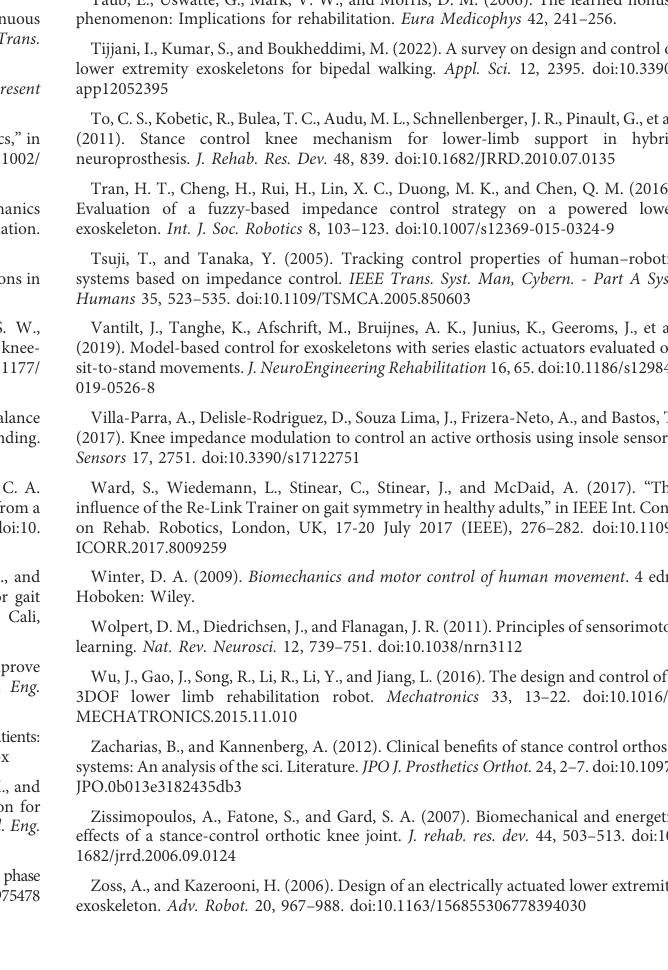
Taborri, J., Palermo, E., Rossi, S., and Cappa, P. (2016). Gait partitioning methods: A systematic review. Sensors 16, 66. doi:10.3390/s16010066 Taborri, J., Rossi, S., Palermo, E., Patanè, F., and Cappa, P. (2014). A novel HMM distributed classi fi er for the detection of gait phases by means of a wearable